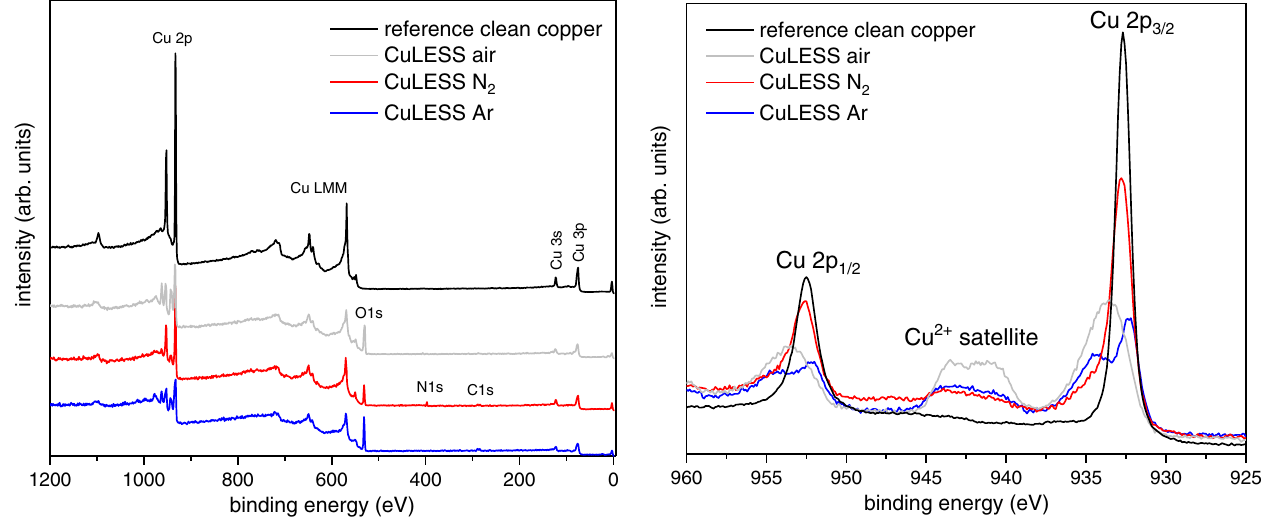
FIG. 7. XPS survey (left) and Cu 2p (right) spectra for samples treated under different atmospheres: nitrogen (red line), argon (blue line), air (gray line), and reference sputtered copper (black